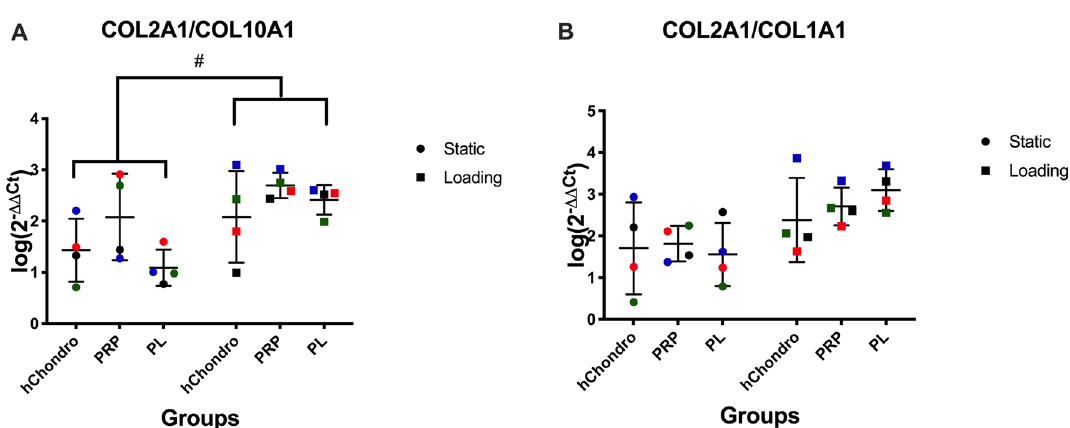
Figure 5. Influence of PRP-Gel, PL supplementation and multi-axial loading on mRNA levels of COL2A1/ COL10A1 ratio ( A ) and COL2A1/COL1A1 ratio ( B ). Relative gene expression (log(2 −ΔΔCT )) was transformed by log(10) and visualized in scatter dot plots with different colors for each donor and lines at mean ± SD, statistical significance was defined as # p <